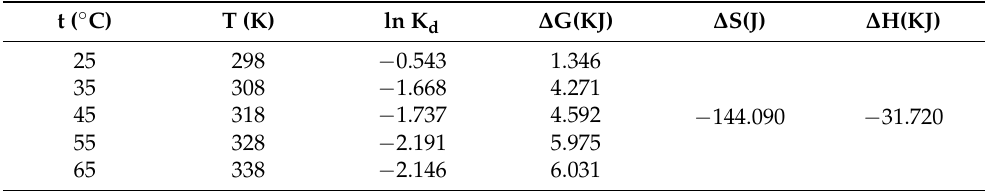
Table 3. Thermodynamic parameters for adsorption of PTZS dye (25 mg/L) at pH = 9 for 30 min.